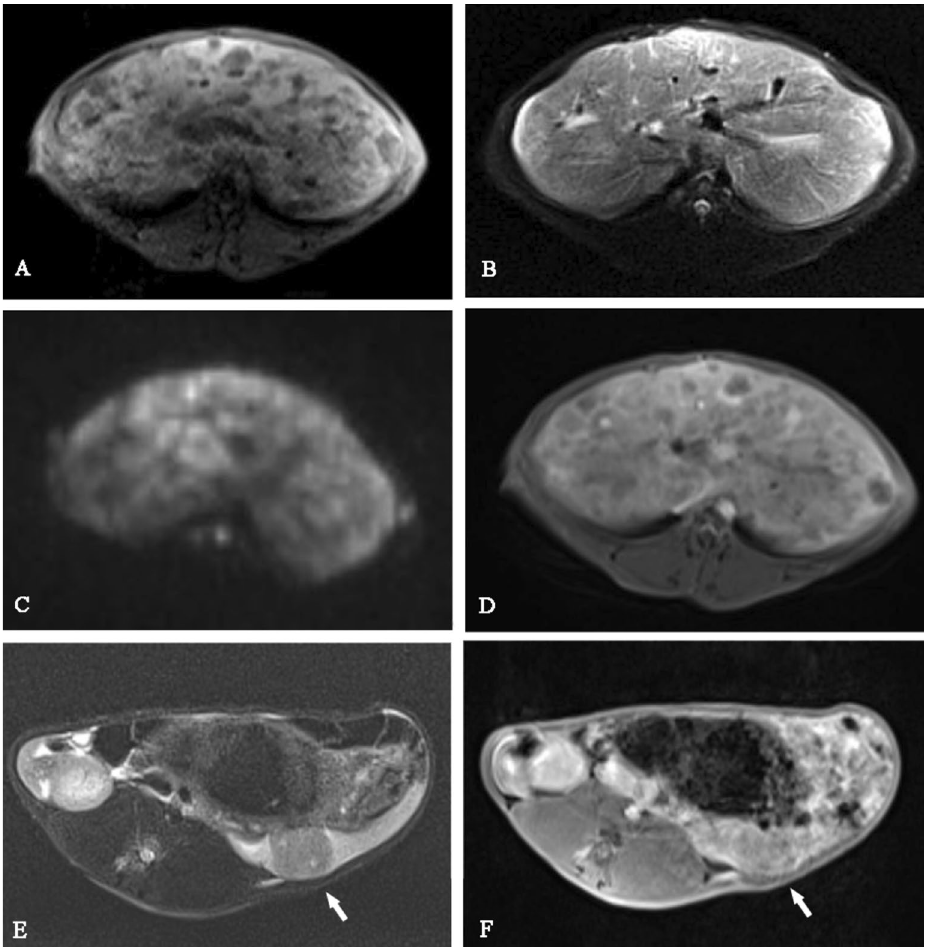
Figure 3. MRI manifestations of liver metastases were multiple nodular and punctate abnormal signal shadows in the liver, low signal on T1WI ( A ), slightly high or equal signal on T2WI ( B ), high signal on DWI ( C ), and circular enhancement on enhanced scanning ( D ); E, F: T2WI and T1WI sequences showed that the liver was enlarged and with a nodular shadow (white arrow).